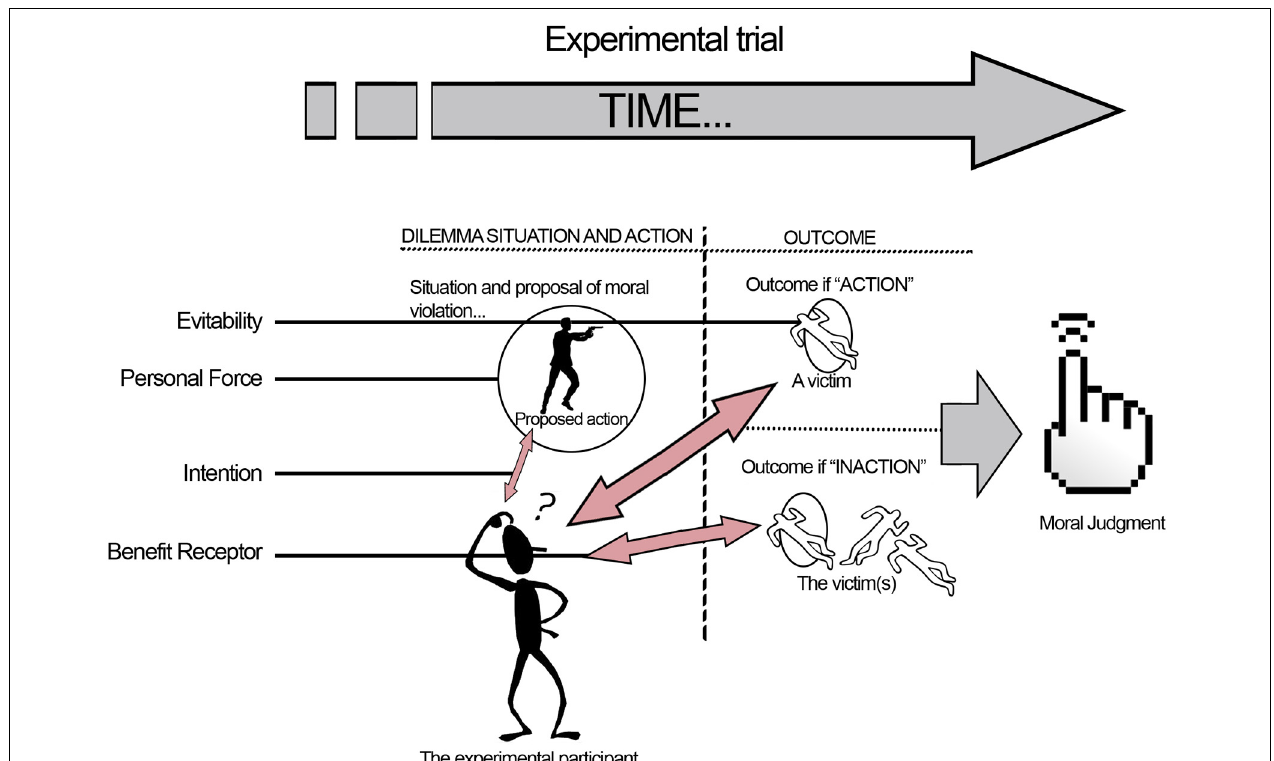
FIGURE 2 | The four factors in the dilemma set, adapted from Christensen and Gomila (2012), reproduced with permission. (1) Personal Force : the kind of imaginary involvement with the situation: Personal, as direct cause, or Impersonal, as an indirect agent in the process of harm. (2) Benefit Recipient : concerns whether the protagonist’s life is at stake (Self-Beneficial action), or not (Other-Beneficial action). (3) Evitability : regards whether the victim would die alongside the other individuals in the group if the moral transgression